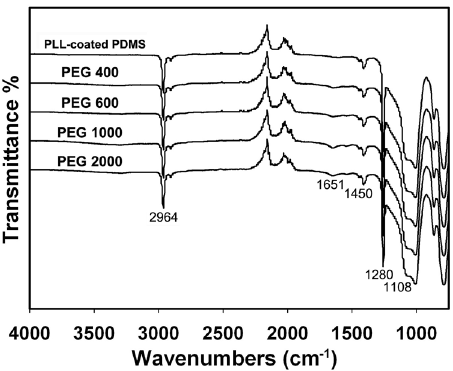
Fig. 2 ATR-FTIR spectra of PLL-coated PDMS and PDMS-PEG-PLL with PEG at various molecular